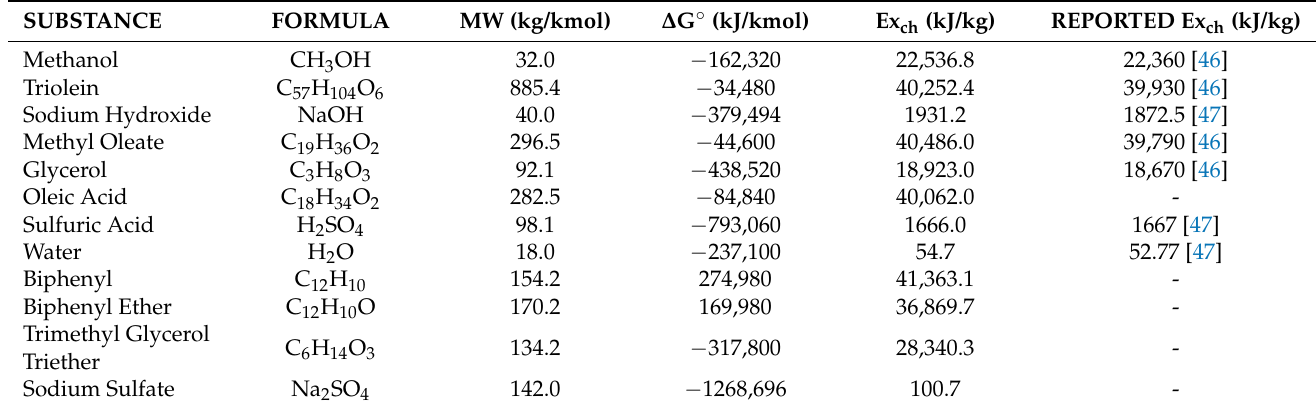
Table 6. Chemical Exergy for all the chemical species in the